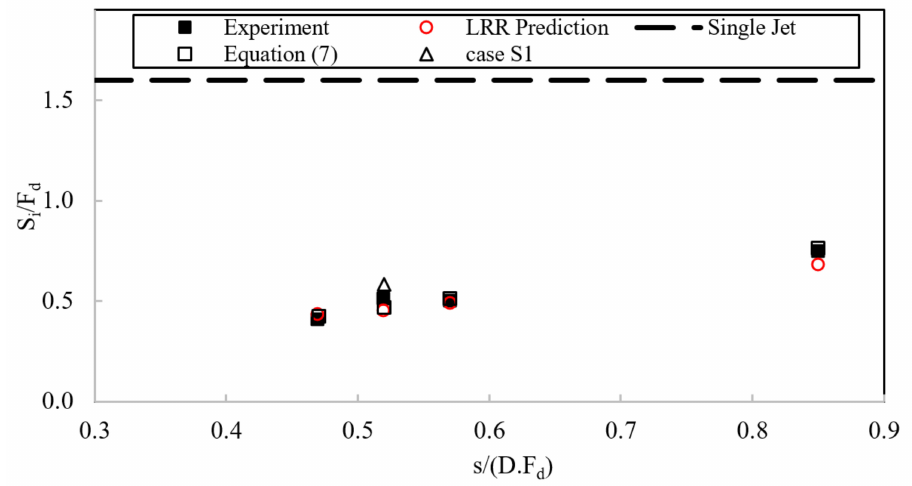
Figure 7. Experimental measurements [19] and numerical results of the normalized impact